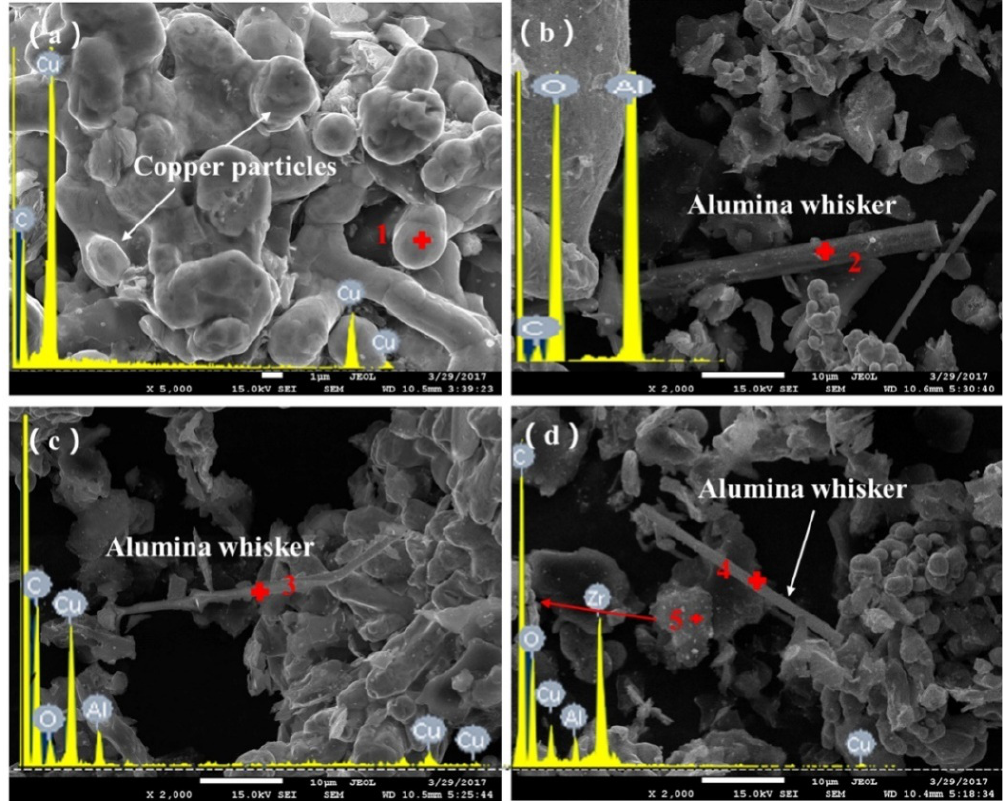
Figure 3. Scanning electron microscopy (SEM) micrographs of powder materials with different contents of alumina whiskers:( a ) 0 wt %; ( b ) 0.5 wt %; ( c ) 1 wt %; ( d ) 1.5 wt %.